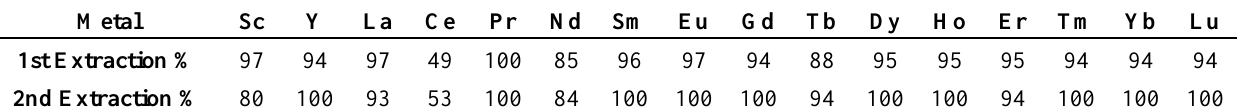
Table 2. Comparison of extraction percentages in first and second extraction times.